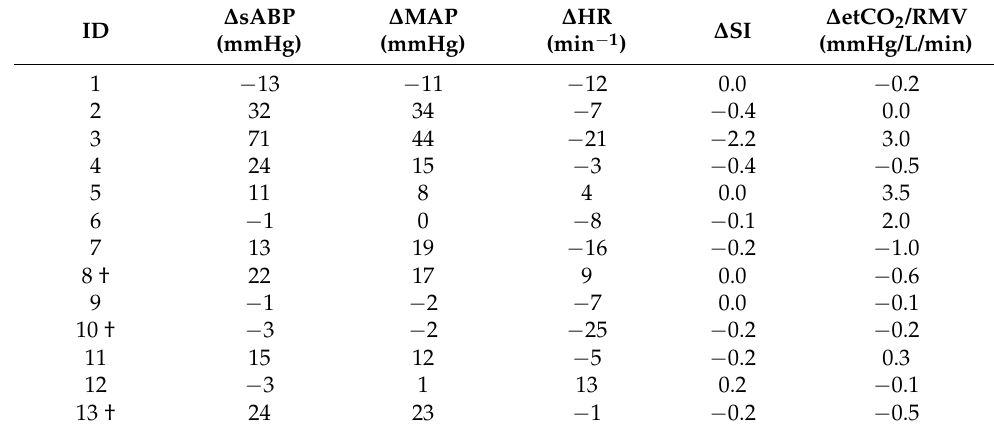
Table 2. Primary outcome parameters from 30 min before to 30 min after C-clamp application in patients with unstable pelvic ring fractures and hemodynamic